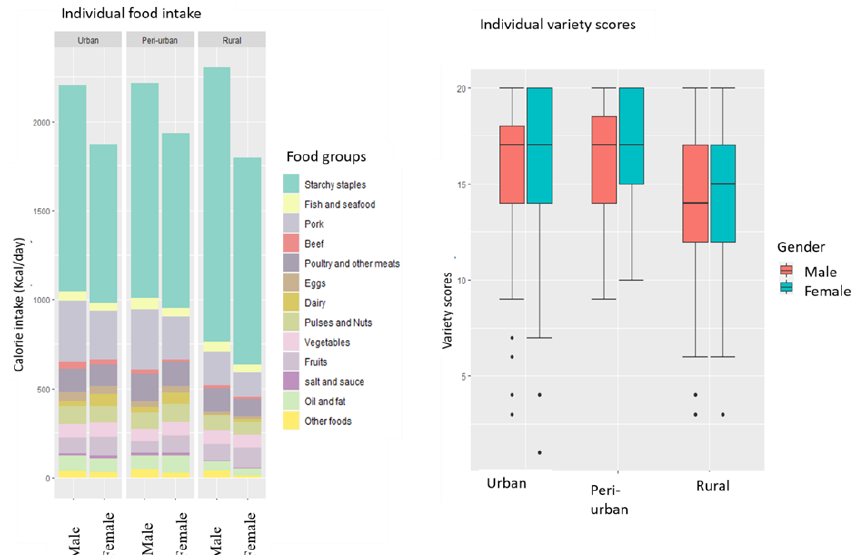
Figure 3. Average individual caloric intake ( left ) and individual variety scores ( right ) by gender and by district. The bar chart shows an average value, and each boxplot shows the distribution of data based on quartiles (the minimum value, the first quartile, the median, the third quartile, and the maximum value and outliers (individual points below bars)).